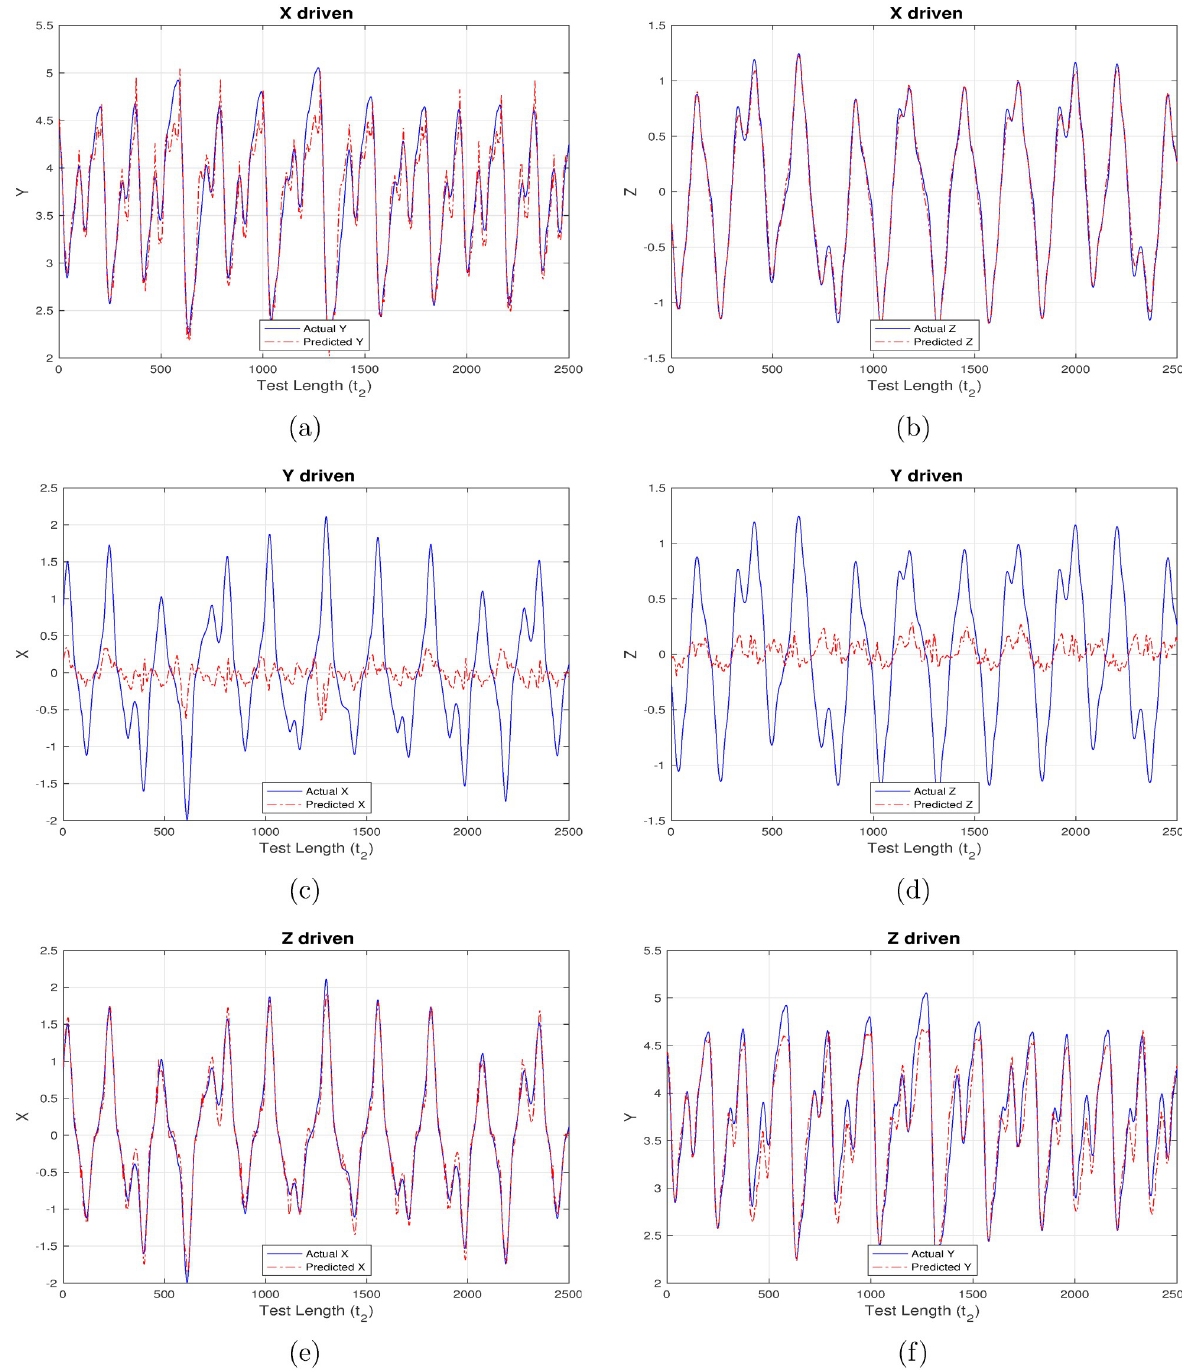
Fig 6. Chaotic financial system component re-generation using “quadratic” activation. (a) Re-generating “investment demand” [Y] behavior with “interest rate” [X] as input (b) Re-generating “price index” [Z] behavior with “interest rate” [X] as input (c) Re-generating “interest rate”[X] behavior with “investment demand”[Y] as input (d) Re-generating “price index” [Z] behavior with “investment demand” [Y] as input (e) Re-generating “interest rate” [X] behavior with “price index” [Z] as input (f) Re-generating “investment demand” [Y] behavior with “price index” [Z] as input.